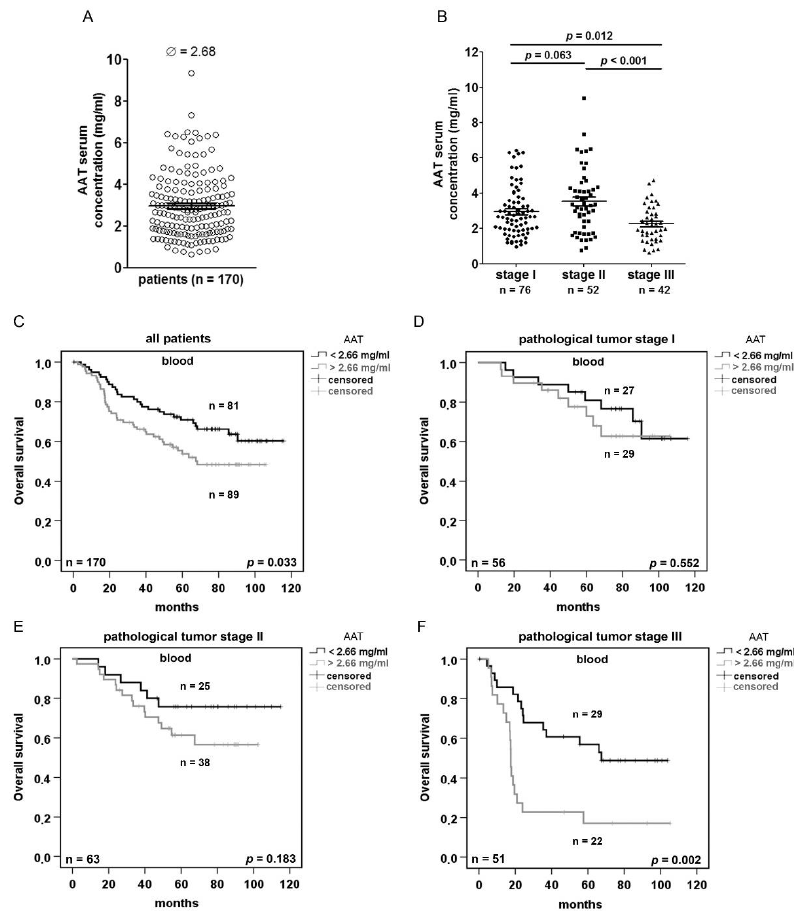
Figure 3. Serum levels of AAT in NSCLC patients increase with advanced tumor stages and are prognostic for the patient’s outcome. ( A ) ELISA based quantification of serum AAT in 170 NSCLC patients. ( B ) Serum concentrations of AAT in patients with stage cancer I, II and III. ( C–F ) Kaplan-Meier overall survival curves using 2.66 mg/mL AAT as cut-off to separate the two groups. p < 0.05 was considered significant.